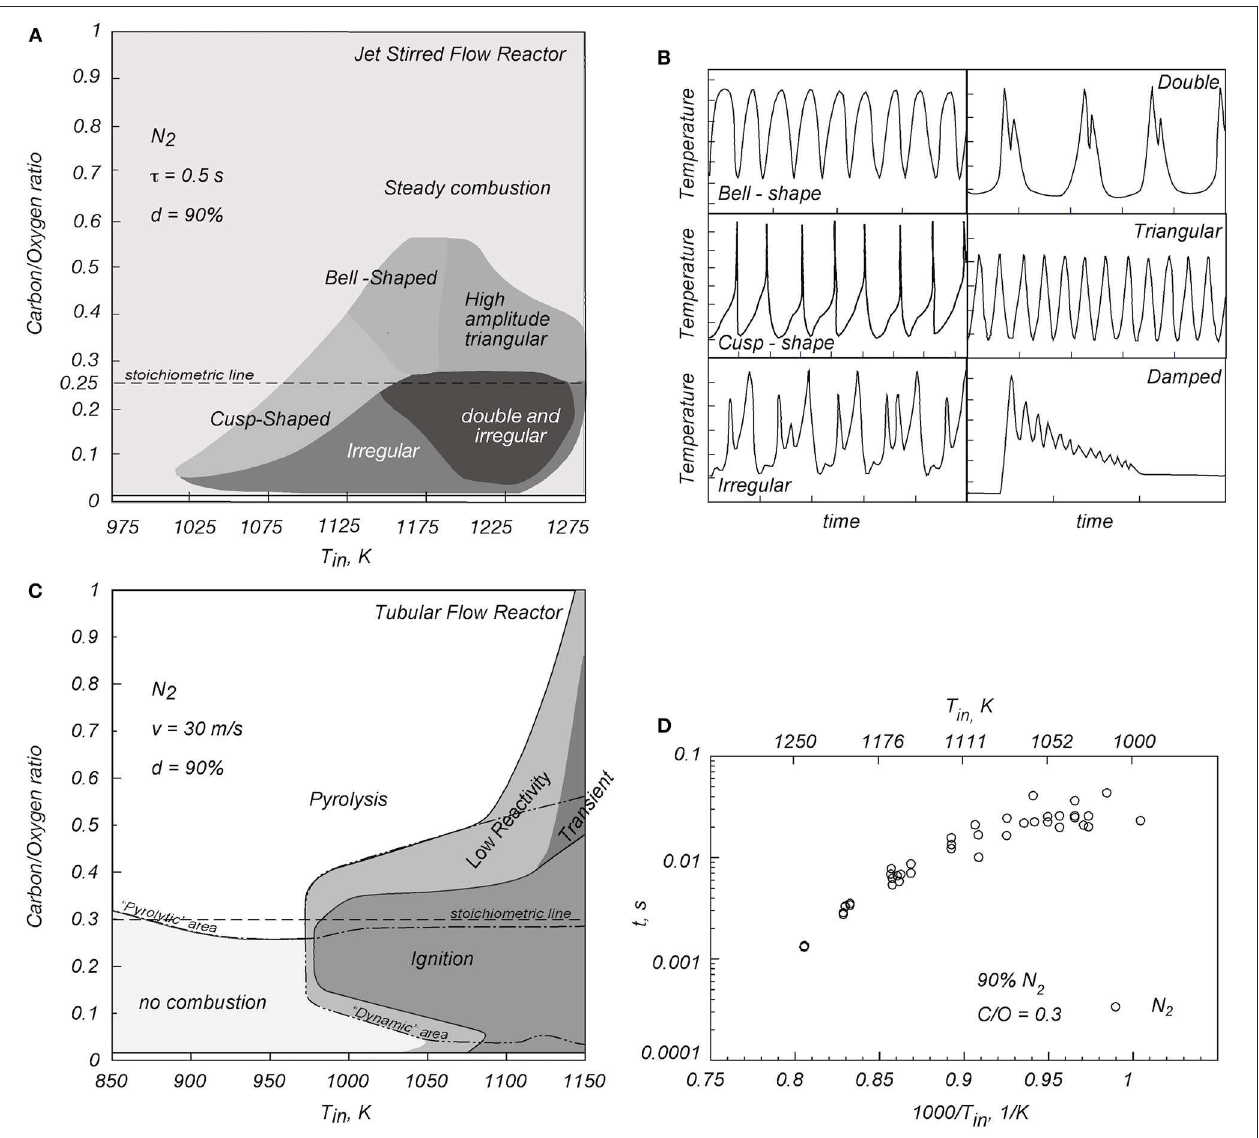
FIGURE 1 | (A,B) Dynamic behaviors and temperature oscillation shapes for a methane/oxygen mixture in a JSFR, from de Joannon et al. (2005). (C,D) Combustion regimes, and NTC-like behavior of autoignition delay times for propane/oxygen mixtures in a TFR, from Sabia et al. (2014).